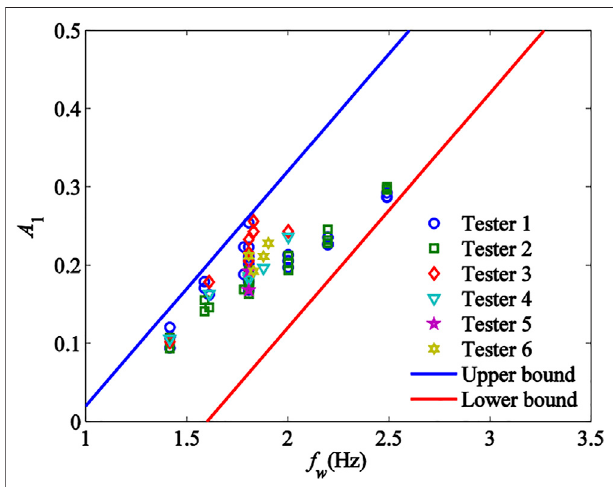
FIGURE 14 | The relation between A1 and fw as well as corresponding fi tting